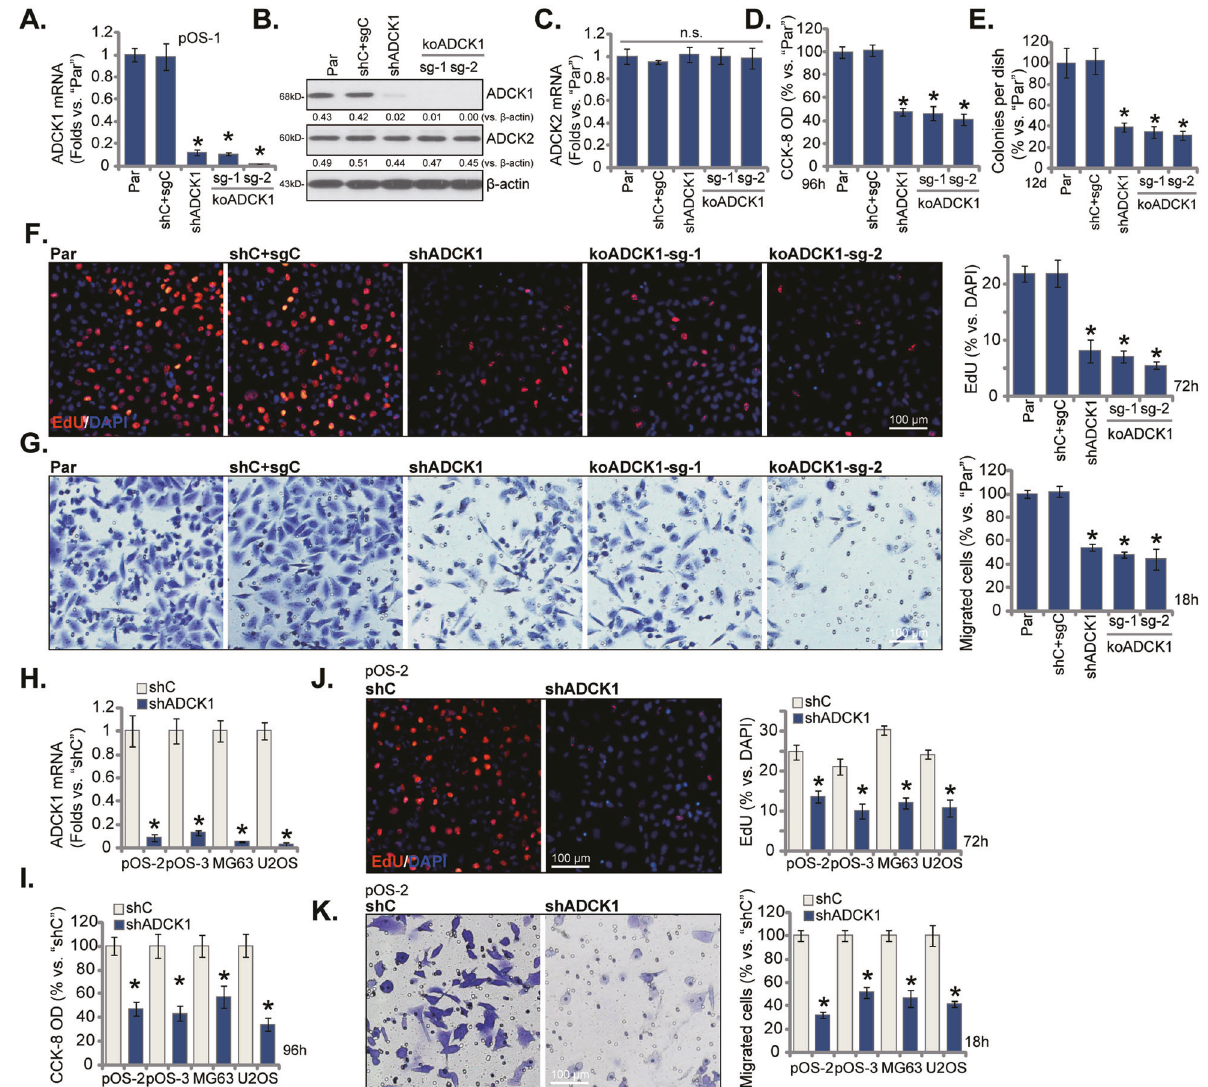
Fig. 2 ADCK1 silencing or KO produces signi fi cant anti-cancer activity in cultured OS cells. Stable pOS-1 primary cells, bearing the lentiviral ADCK1 shRNA ( “ shADCK1 ” ), the lentiviral CRISPR/Cas9 construct with sgRNA targeting ADCK1 , “ koADCK1-sg-1 ” and “ koADCK1-sg-2 ” , or the lentiviral scramble control shRNA plus the CRISPR/Cas9 empty vector ( “ shC + sgC ” ), were established, mRNA and protein expression of ADCK1 and ADCK2 was tested by qRT-PCR and Western blotting assays ( A – C ); Cells were further cultured for applied time periods, colony formation ( D ), cell viability (CCK-8 OD, E ), proliferation (nuclear EdU staining, F ), migration ( “ Transwell ” assays, G ) were tested by the listed assays. The primary human OS cells (pOS-2 and pOS-3) as well as the established lines (MG63 and U2OS), expressing the lentiviral ADCK1 shRNA ( “ shADCK1 ” ) or the lentiviral scramble control shRNA ( “ shC ” ), were established, ADCK1 mRNA expression was tested by qRT-PCR assays ( H ); Cells were further cultured for applied time periods, cell viability ( I ), proliferation ( J ), and migration ( K ) were tested similarly. “ Par ” stands for the parental control cells. Data were presented as mean ± standard deviation (SD, n = 5). * P < 0.05 vs. “ Par ” / “ shC ” cells. “ n.s. ” stands for non- statistical difference ( C ). The experiments were repeated fi ve times with similar results obtained. Scale bar = 100 μ m ( F , G , J , K